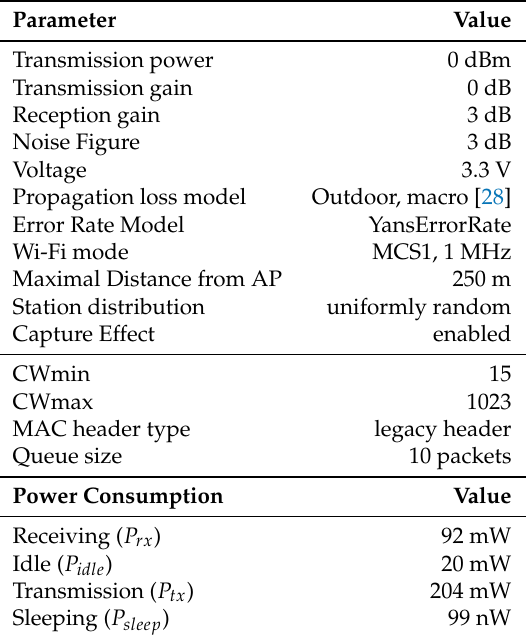
Table 3. Default PHY and MAC layer parameters used in our